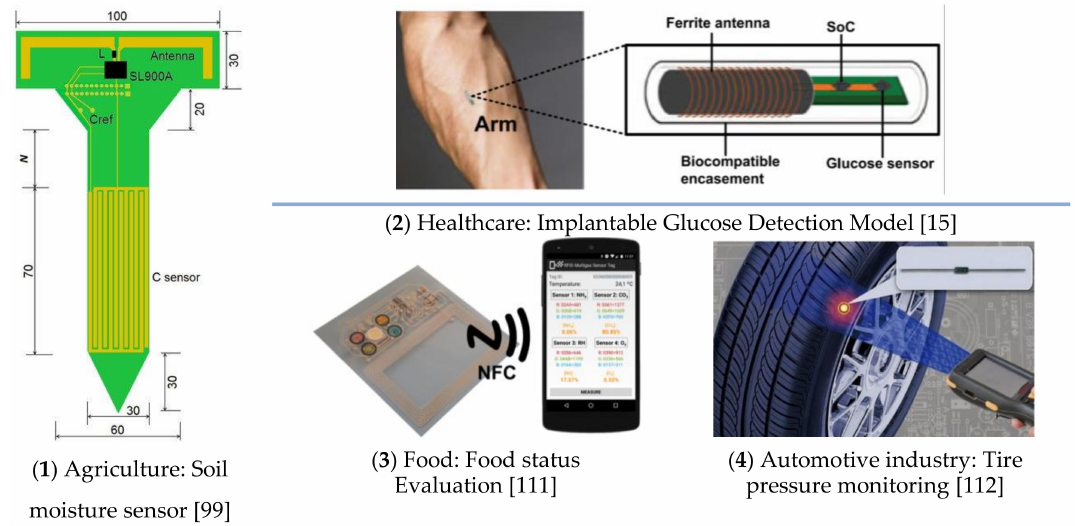
Figure 12. Typical Application of RFID